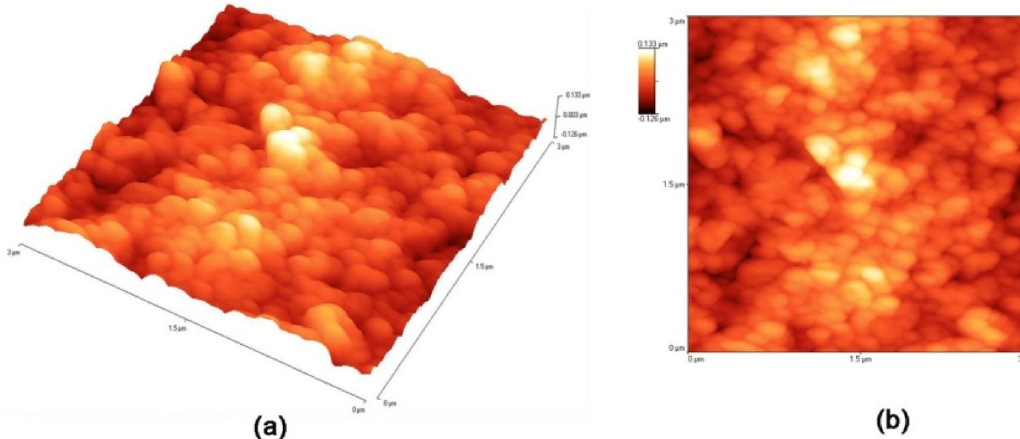
Figure 2. AFM surface image of INCP film.